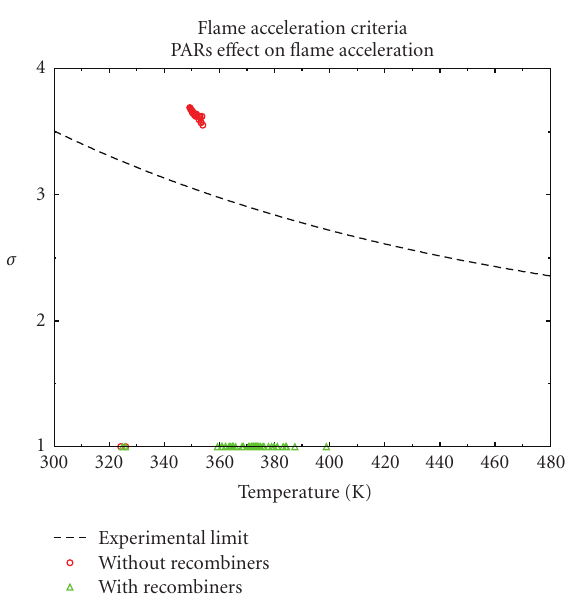
Figure 7: PARs e ff ect on Flame acceleration (in red: gas composi- tion without PARs; in green: gas composition with